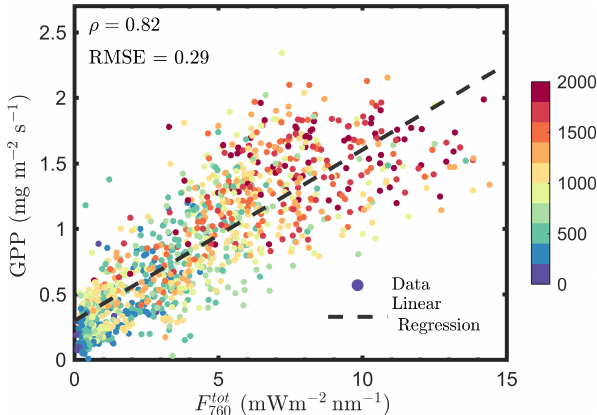
Figure 14. Relationships between far-red total emitted SIF by the canopy ( F tot ) and GPP. F tot was estimated by using the fluores- 760 760 cence correction vegetation index